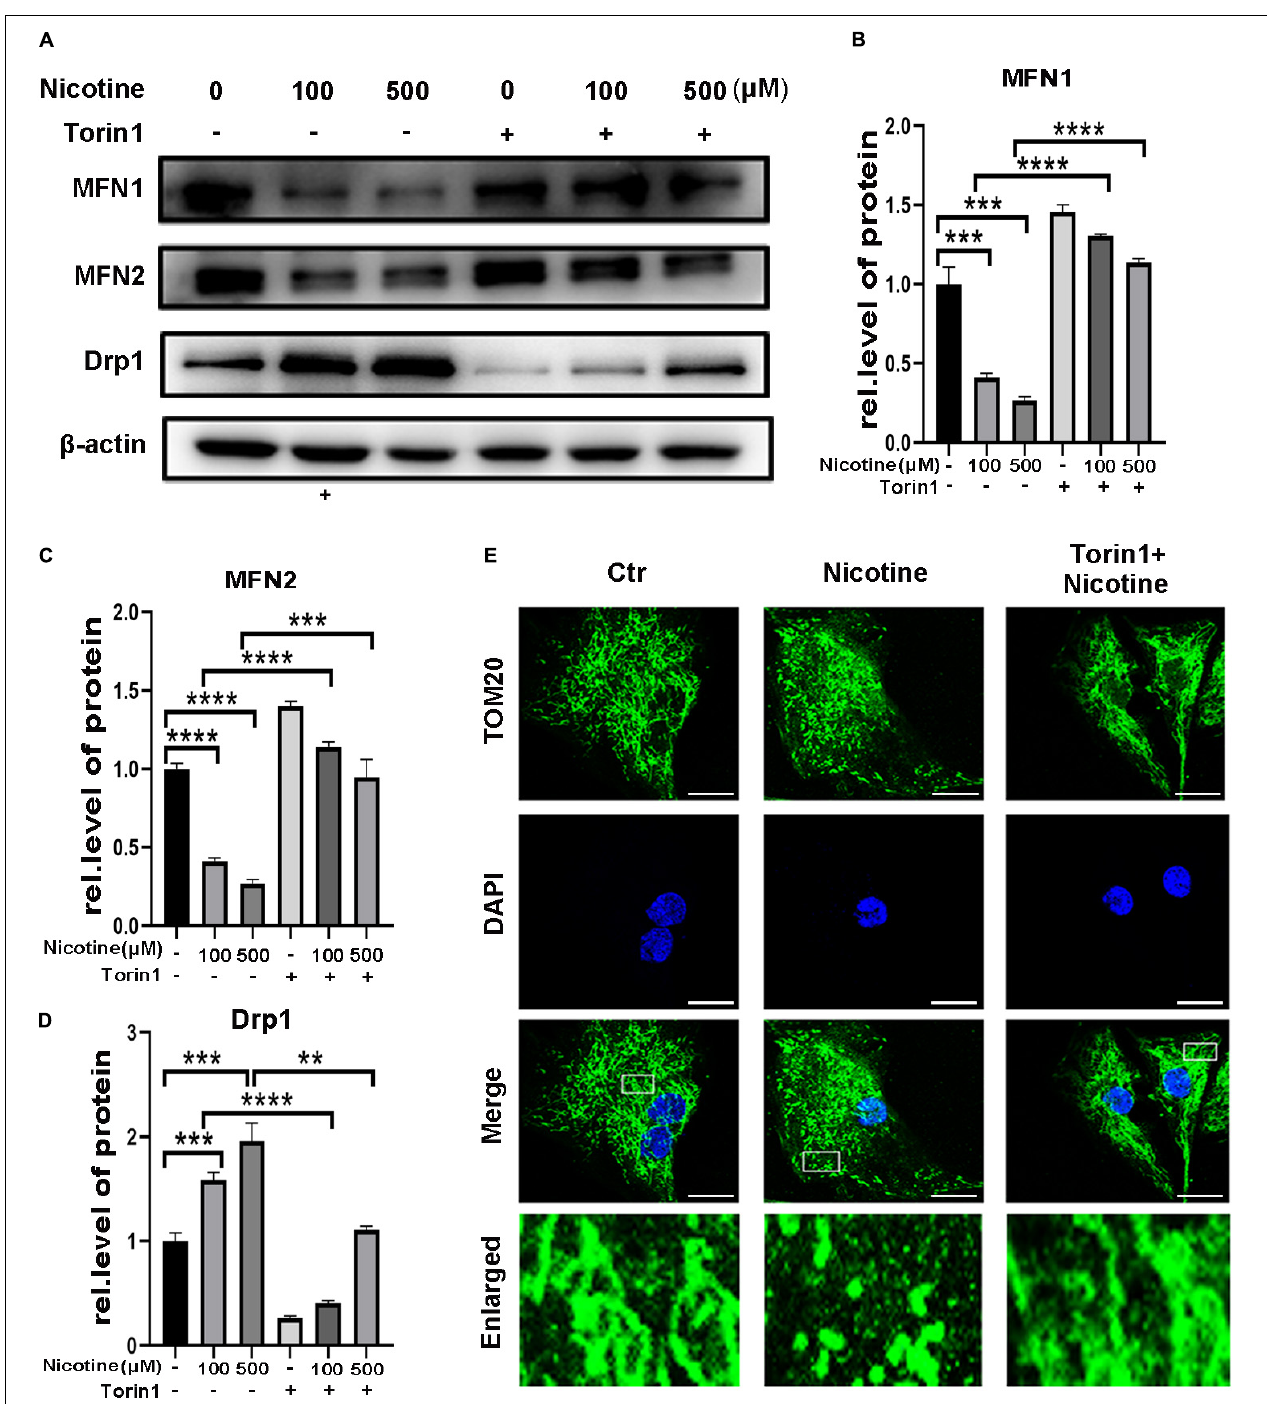
FIGURE 4 | Torin1 relieved mitochondrial dynamics disorder induced by nicotine. (A) Western blotting was performed to detect mitochondrial dynamics factors with pretreatment of Torin1. (B–D) Protein levels were quantified by Image J. (**** p < 0.0001; *** p < 0.001; ** p < 0.01, n = 3). (E) Confocal microscopy was used to detect the mitochondrial morphology with the treatments of Torin1 (Scale bar = 10 µ